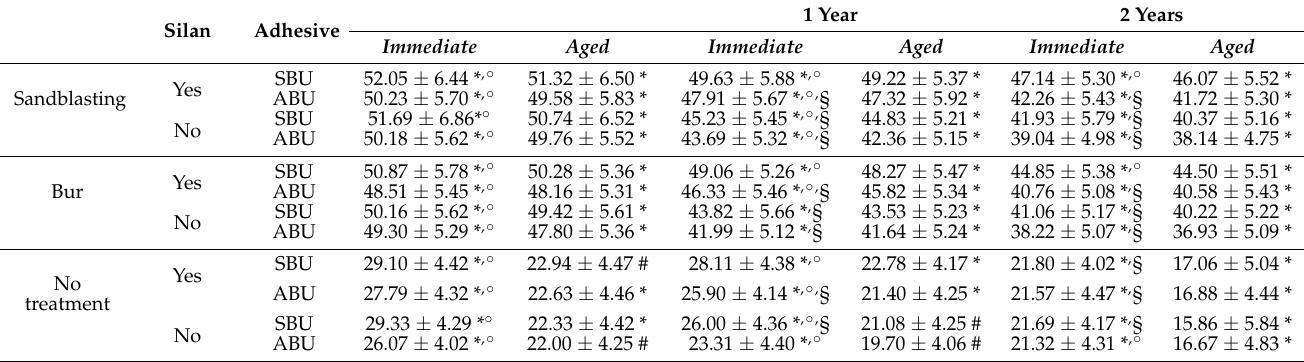
Table 3. The means and standard deviations ( µ TBS in MPa ± SD) of repair strength of bulk-fill resin composite for all experimental groups.